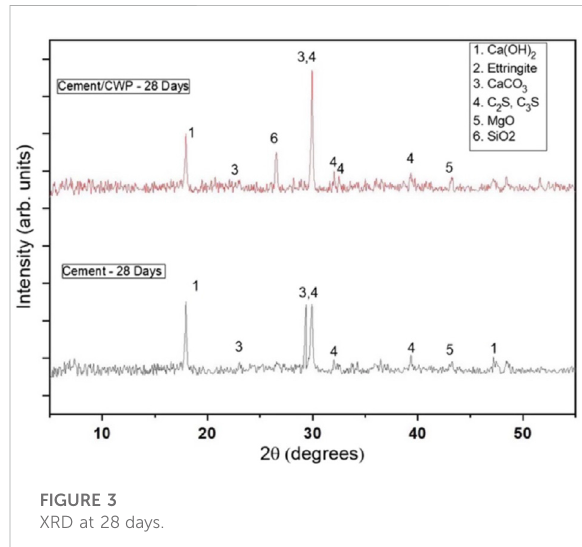
FIGURE 3 XRD at 28